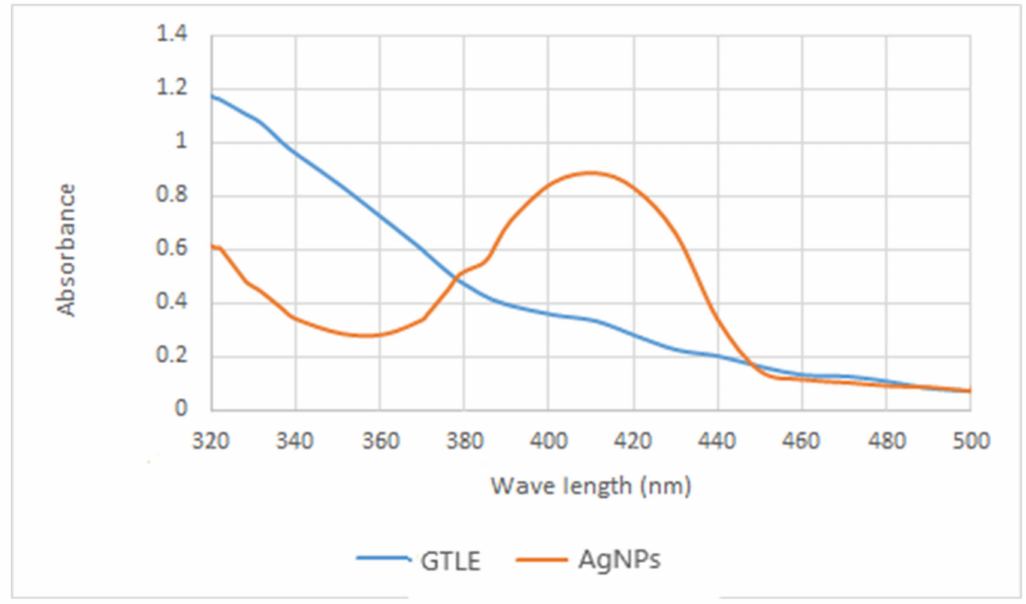
Figure 2. UV spectrum of the biosynthesized AgNPs by GTLE compared to GTLE.